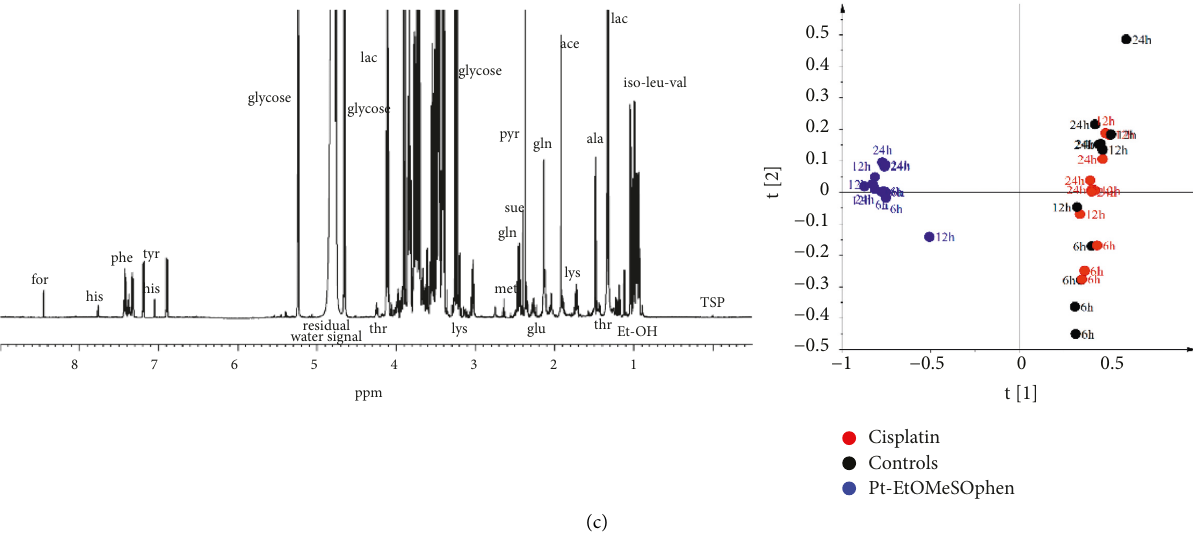
Figure 2: Representatives 600MHz 1 H NMR spectra (left panels) and corresponding PCA score plot models (right panels) of SH-SY5Y cells: (a) aqueous extracts ( R 2 X � 0.566; Q 2 � 0.297); (b) lipid extracts ( R 2 X � 0.946; Q 2 � 0.913); and (c) growth media ( R 2 X � 0.879; Q 2 � 0.851). Iso: isoleucine, leu: leucine, val: valine, but: butyrate, lac: lactate, thr: threonine, ala: alanine, ace: acetate, glu: glutamate, gln: glutamine, GSH: glutathione, lys: lysine, for: formate, met: methionine, pyr: pyruvate, suc: succinate, cre: creatine, cre-P: creatine phosphate, cho: choline, PC: phosphocholine, GPC: glycerophosphocholine, m-ino: myo-inositol, phe: phenylalanine, tyr: tyrosine, his: histidine, tau: taurine, gly: glycine, ser: serine, UDP-glucose: uridine diphosphate glucose, AXP: adenosine mono- (M), di- (D), triphosphate (T), PTC: phospha- tidylcholine, GPL: